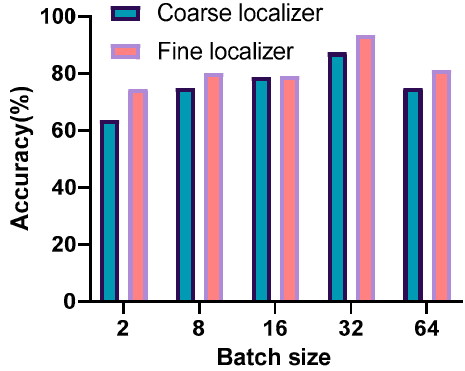
Figure 15. Positioning performance with different batch sizes.